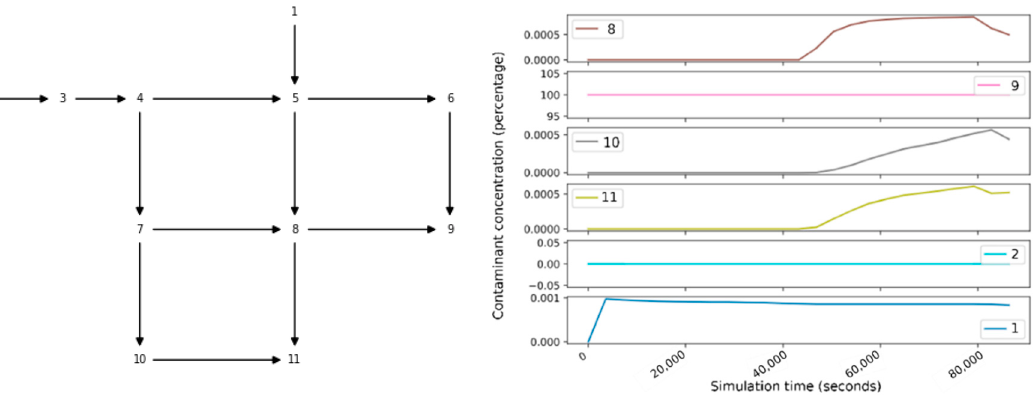
Figure 1. A schematic representation of the Net1 synthetic example ( left ). Concentrations of the contaminant introduced at Node 9 for Nodes 1, 2, 8, 9, 10, and 11 ( right